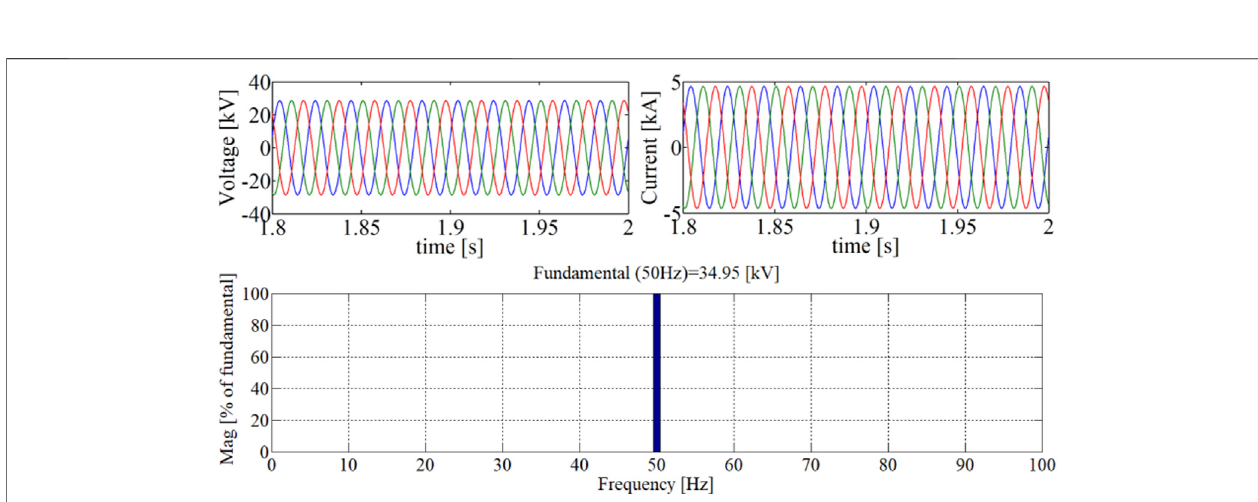
FIGURE 13 | Three-phase voltage and current at the 35-kV side of transformers and the FFT of voltage with 35-kV cable of 15 km.